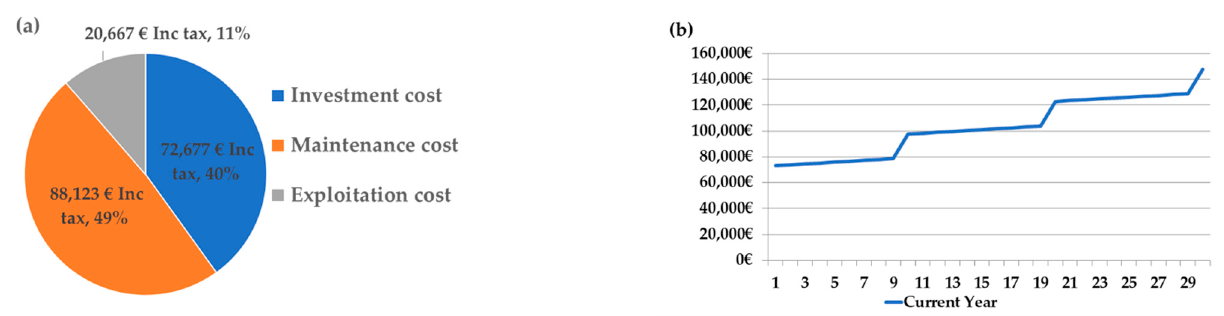
Figure 4. The 30-year financial report: ( a ) Distribution of the global cost; ( b ) evolution of the global cost by year.